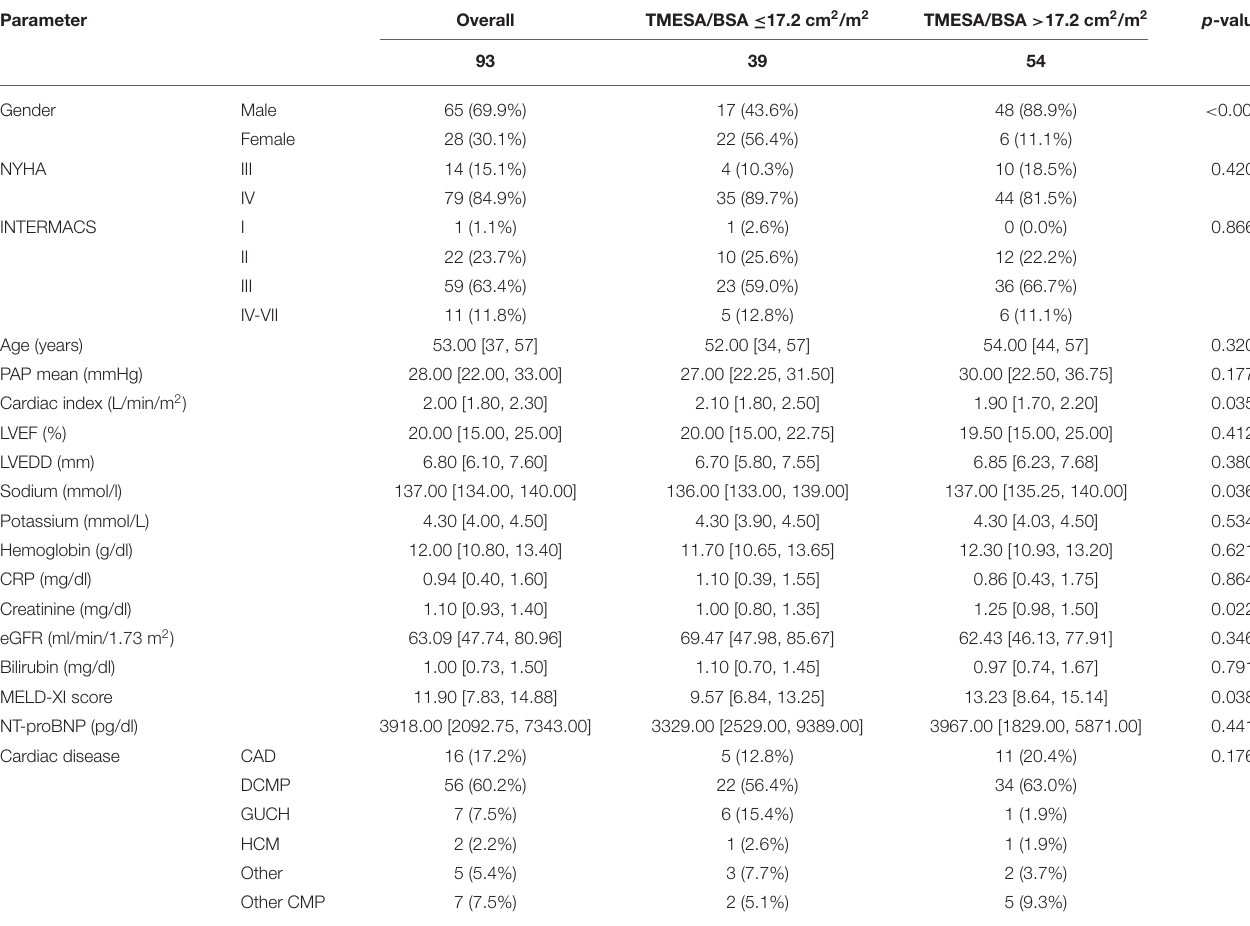
TABLE 2 | Baseline characteristics at time of waiting list registration in status “high urgent”: patients with reduced muscle area vs. patients with TMESA/BSA > 17.2 cm 2 /m 2 .